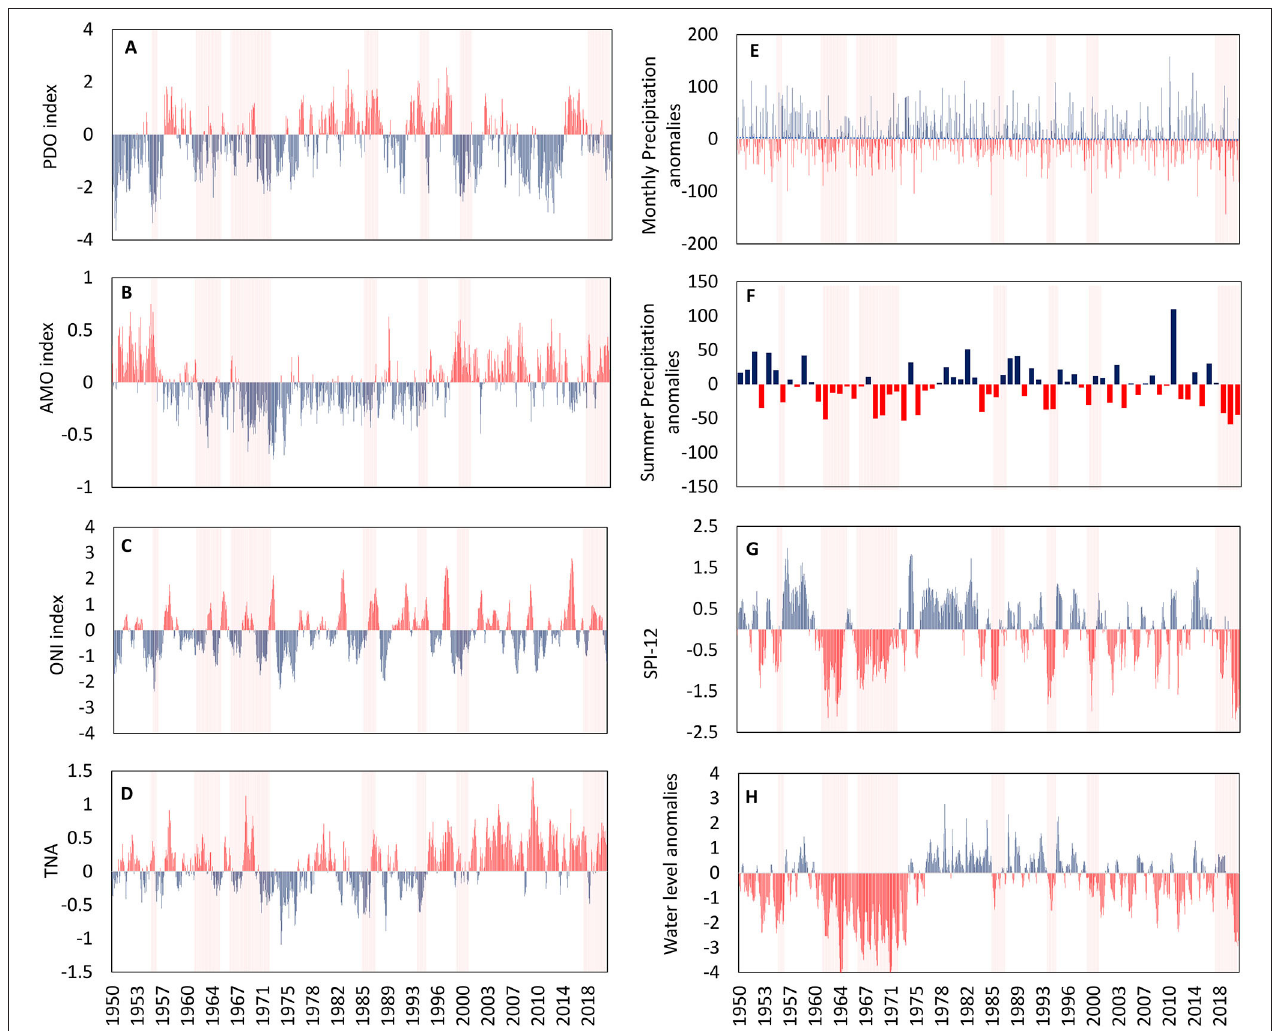
FIGURE 5 | Monthly variability of teleconnection indices at monthly level from 1960 to 2020 (September): (A) PDO, (B) AMO, (C) ONI, (D) TNA, (E) monthly precipitation anomalies, (F) summer (December-March) precipitation anomalies, (G) SPI-12, (H) water level anomalies at Ladário. Red bars represent years with drought as defined by SPI-12 < − 1.00. Base period is 1981–2010 (Sources of data: NOAA, Brazilian Navy,